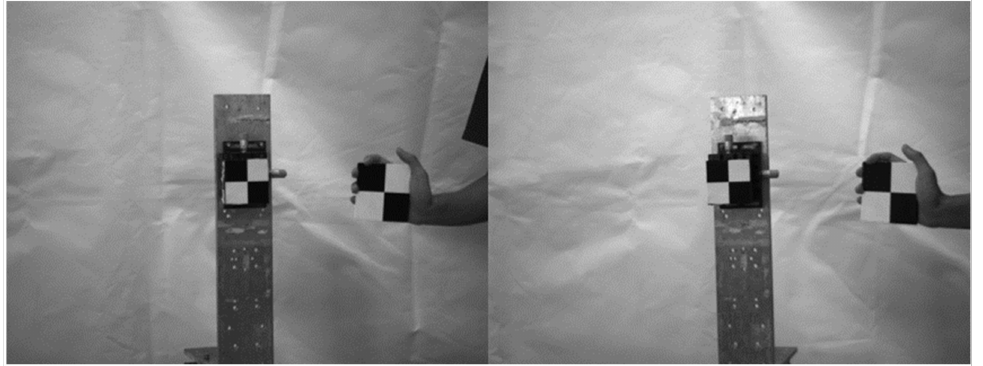
Figure 10. Corner targets in the FOV.